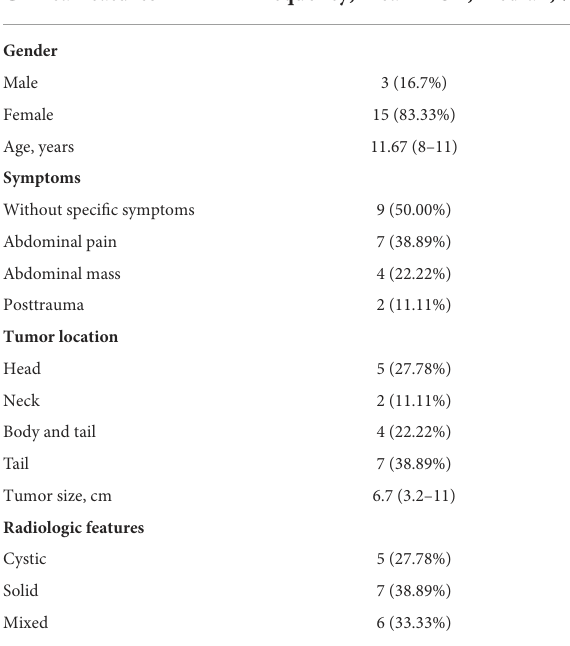
TABLE 1 Basic clinical characteristics of the patient. Clinical